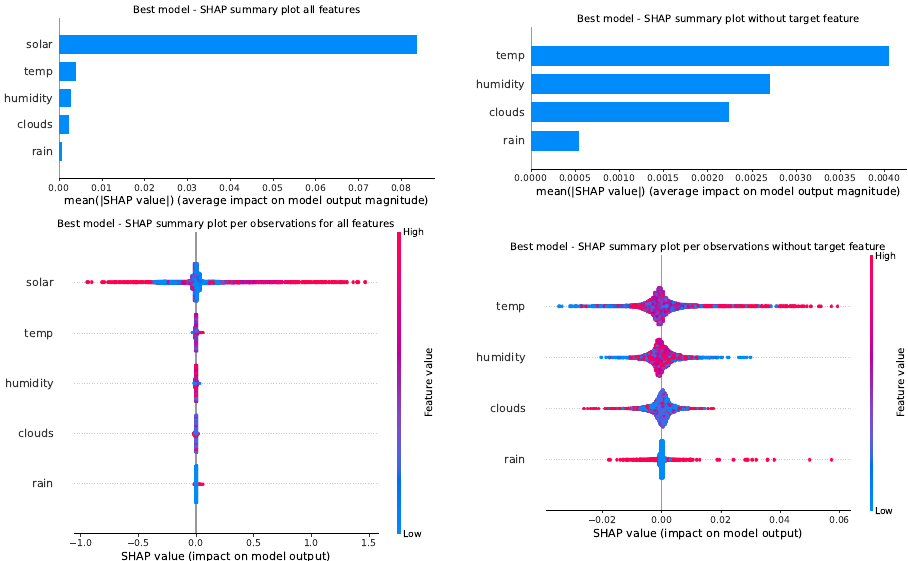
Figure 13. SHAP summary plots for executed tests with respect to the LSTM-HRSA optimized